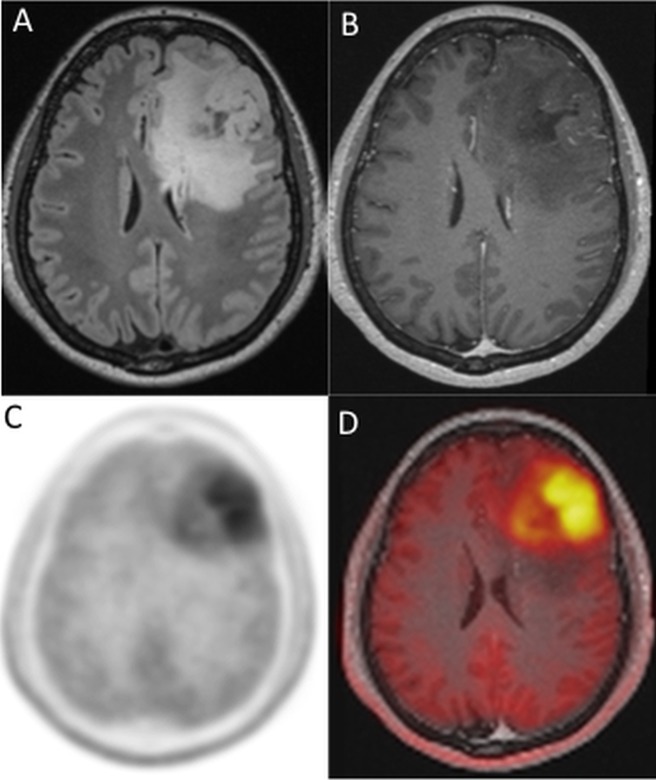
Astrocytoma WHO grade III.20-year old woman with left frontal tumor with FLAIR- hyperintensity (A) and minimal contrast enhancement (B); leading to a diagnosis of an astrocytoma WHO grade III by MRI alone. In methionine-PET an intensive tracer more-uptake (T/N ratio 4.9) of this lesion is seen (C, D fused), making diagnosis of an astrocytoma WHO grade III with an oligodendroglial component more likely.